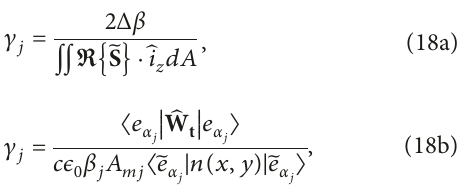
� 2 . 05, n � 1 . 0, c cl